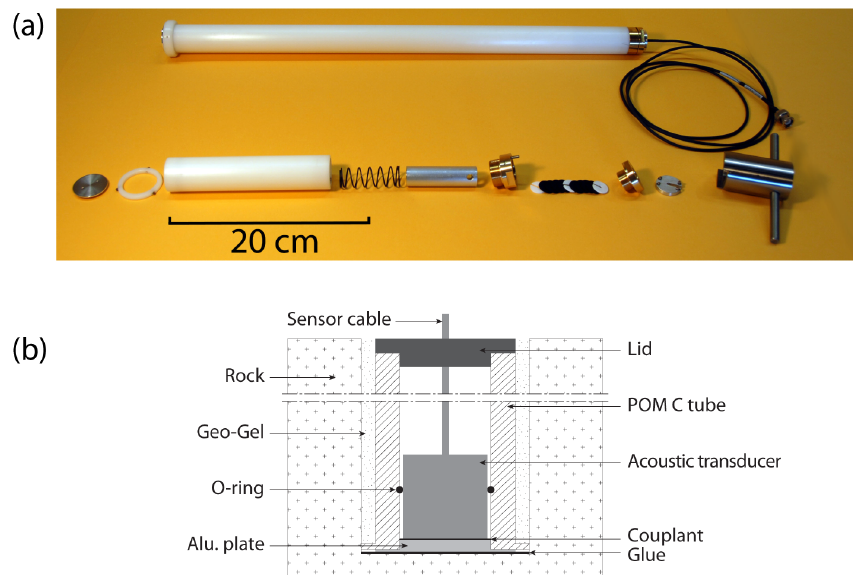
Fig. 5. (a) Picture of two copies of the AE casing, disassembled (bottom panel) and assembled (top panel). (b) Schematic view of the casing and acoustic transducer in a borehole.